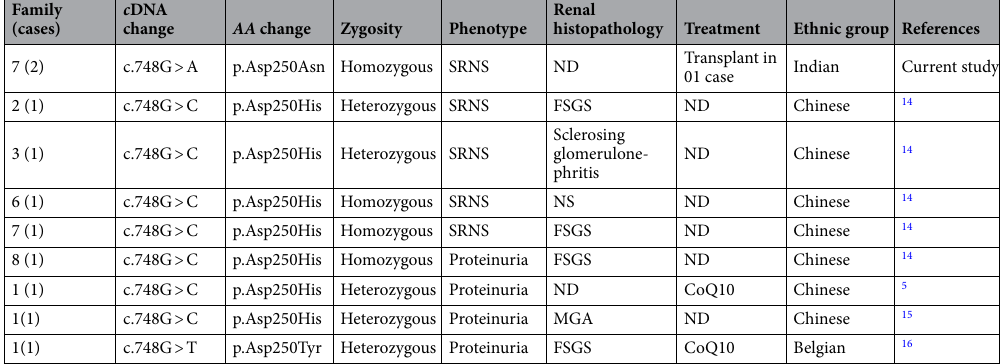
Table 1. Genotypic and phenotypic characteristics of COQ8B variants (at position chr19:41209497) in children. ND Not done or no data, NS nephrotic syndrome, FSGS focal segmental glomerulosclerosis, MGA minor glomerular